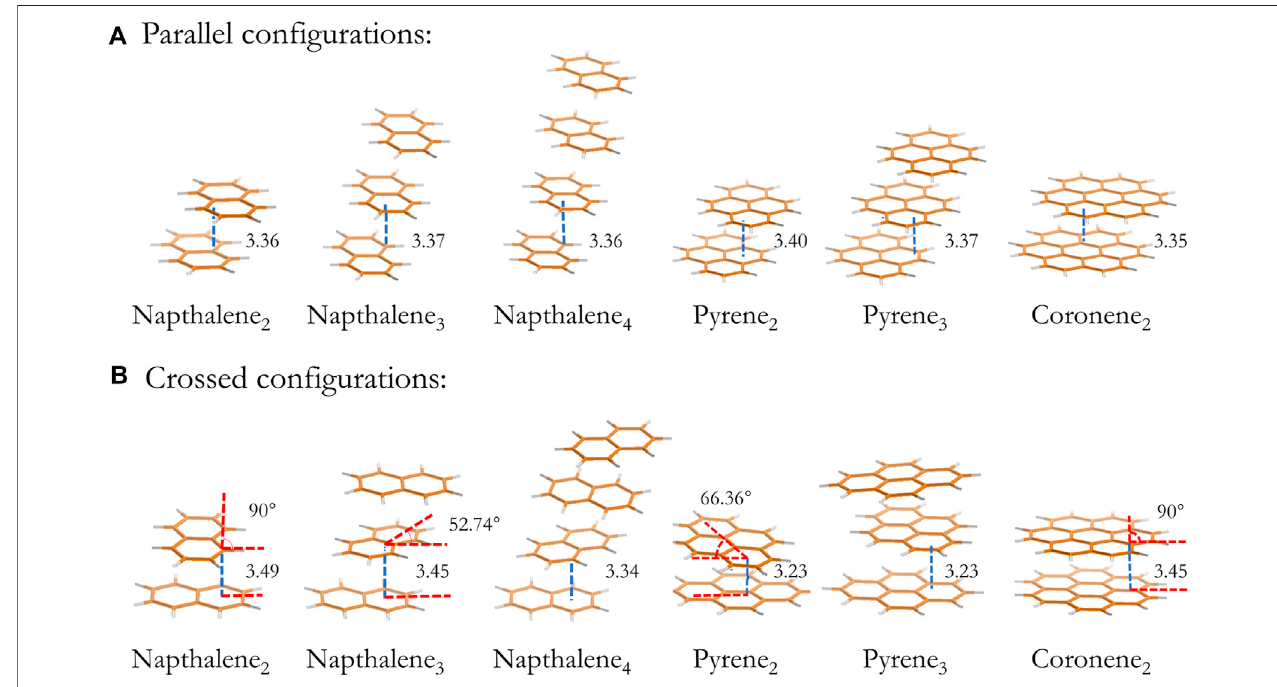
FIGURE1| Optimizedcon fi gurationsofnaphthaleneclusters.Thesizeofclusterfrom left to right isdimertotetramer.The upper and lower panelpresentsalocal minimum with a parallel (A) and a crossed (B) con fi guration, respectively. The layer separation and the rotation angle between planes are indicated on the fi gure.